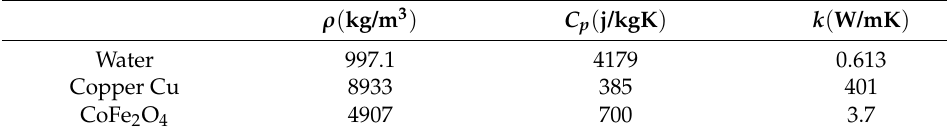
Table 1. The experimental values of water and nano particulates